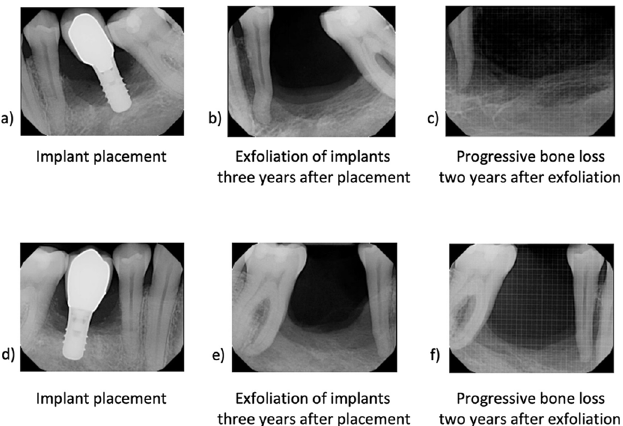
Fig. 5. Periapical radiographs of implant site and exfoliation. (a) Implant placement, (b) exfoliation three years later, and (c) progression of bone loss two years after implant exfoliation at the site of the left mandibular second premolar. (d) Implant placement, (e) exfoliation three years later, and (f) progression of bone loss two years after implant exfoliation at the site of the right mandibular fi rst molar.